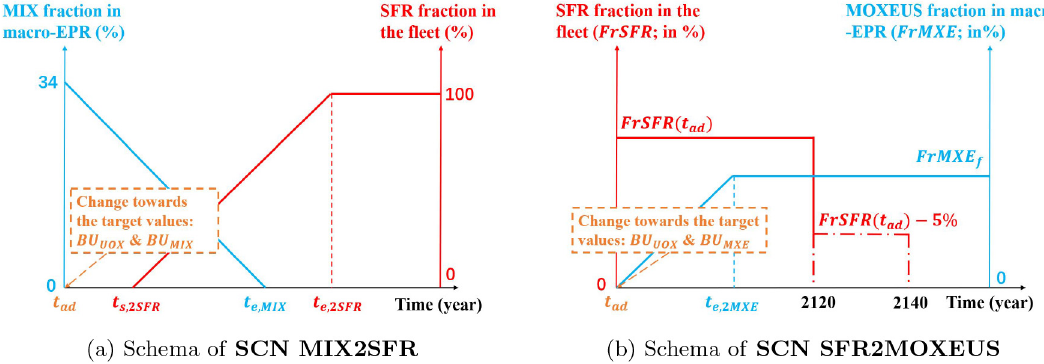
Fig. 4. Description of SCN MIX2SFR and SCN SFR2MOXEUS . Table 1. Ranges of input variables in the adaptation scenario SCN MIX2SFR . Var. Min. Max. Unit Explanation t e,MIX t ad + 1 max( t ad + 1 , 2095) year t to end the use of MIX. 2120 year t to start the 1 st SFR. 2150 year t to reach 100%